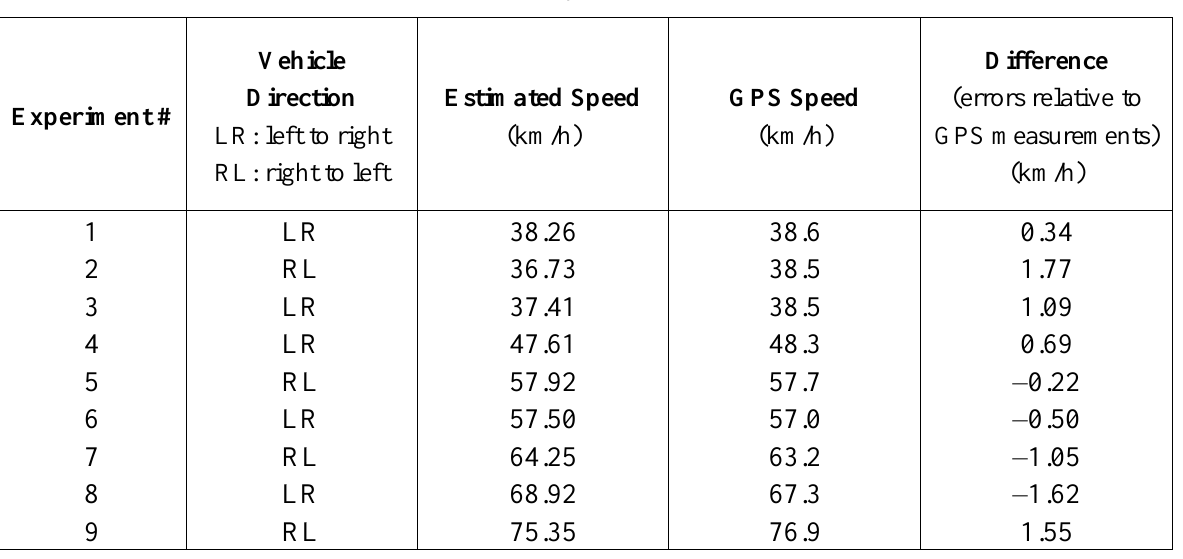
Table 5. Accuracy test